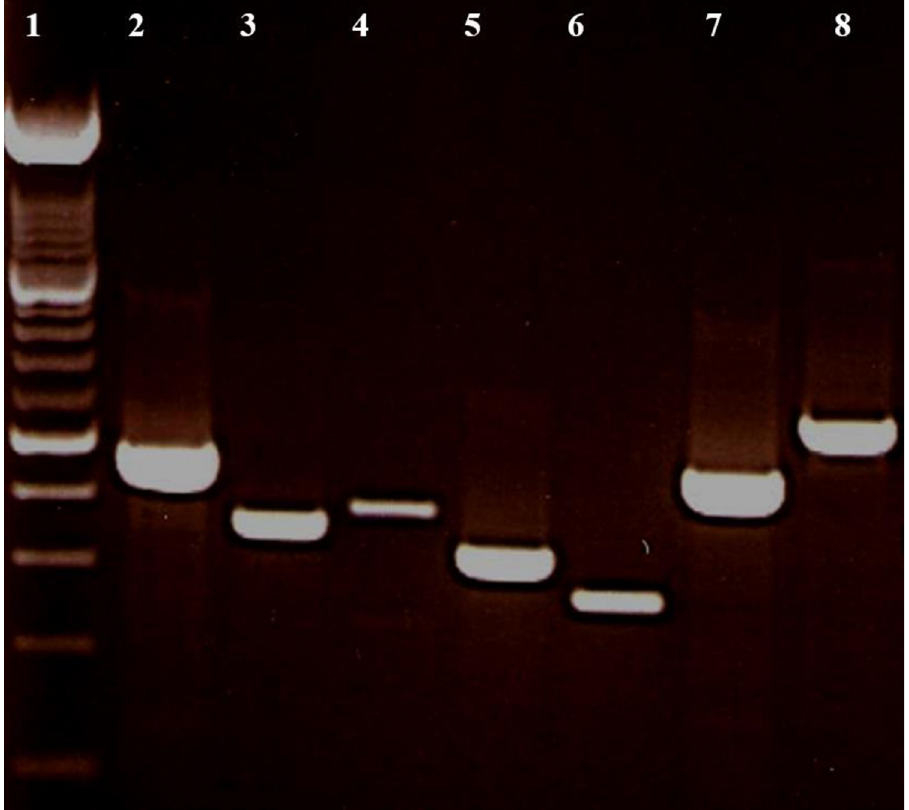
Fig 1. The amplified product of enterotoxins and TSST-1. Lane 1: 100 bp ladder; Lane 2: enterotoxin seb ; Lane 3: enterotoxin seh ; Lane 4: enterotoxin sed ; Lane 5: enterotoxin seg; Lane 6: enterotoxin sec; Lane 7: enterotoxin sei ; Lane 8: toxic shock toxin ( tst )